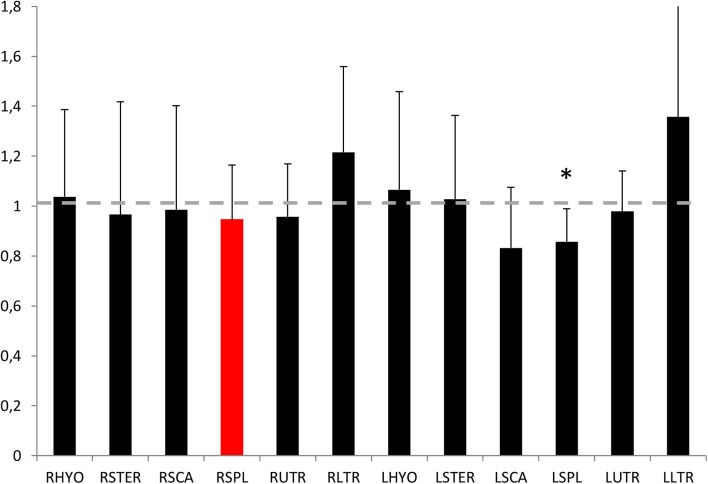
Integrated EMG amplitude for each muscle.Average and SD of the integrated EMG amplitude recorded for each muscle in the painful condition normalized relative to the baseline condition. The gray dotted line indicates the level of activity which would be comparable between conditions. The injected muscle, the right splenius capitis is highlighted in red; note the overall decreased activity of this muscle. Other muscles showed either an increase or decrease of activity across all subjects. (Right–R and Left–L: Sterno Hyoideus–HYO, Sternocleidomastoideus-STER, Anterior Scalenus-SCA, Splenius Capitis–SPL, Upper trapezius-UTR, Lower Trapezius-LTR).